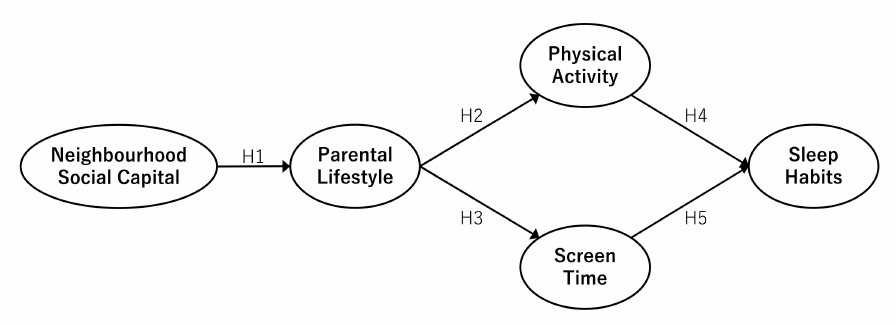
Figure 1. Hypothesized model.